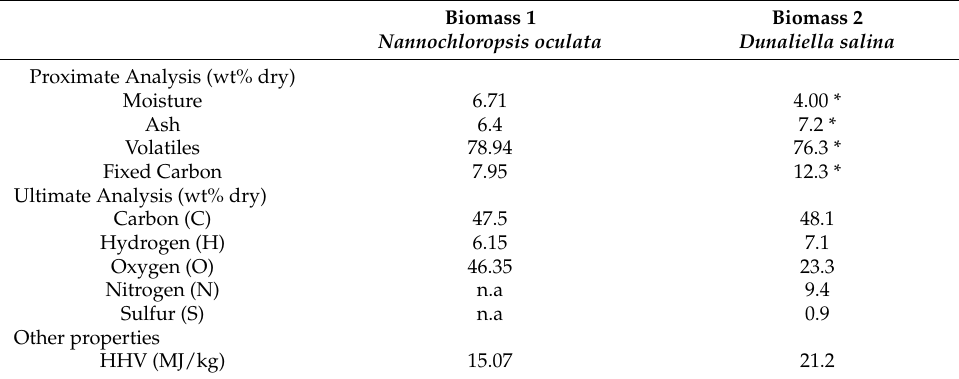
Table 2. Specification of microalgae used in this study